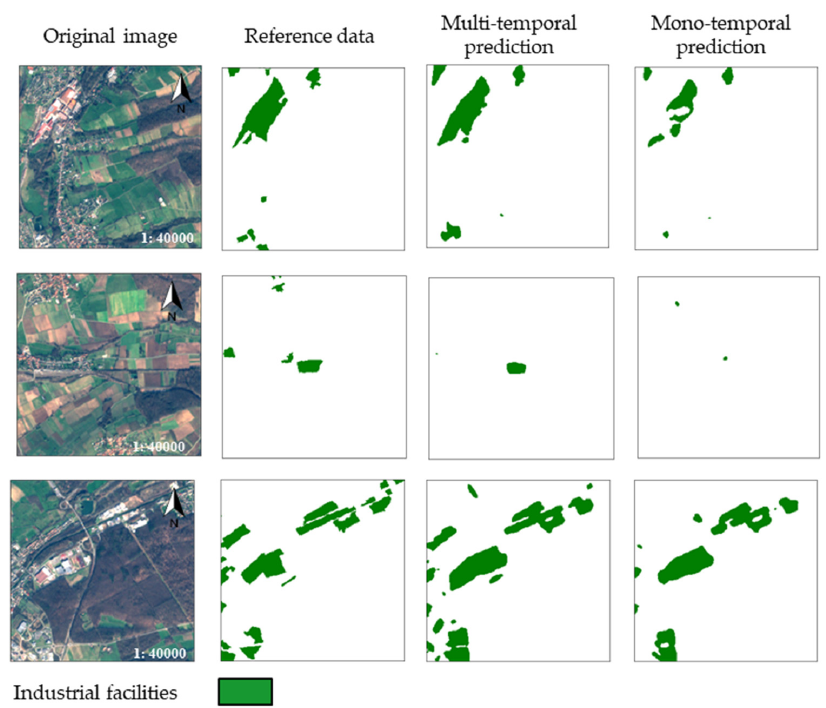
Figure 15. Comparison between predictions of the mono-temporal UNet and the multi-temporal UNet for the class of industrial facilities.